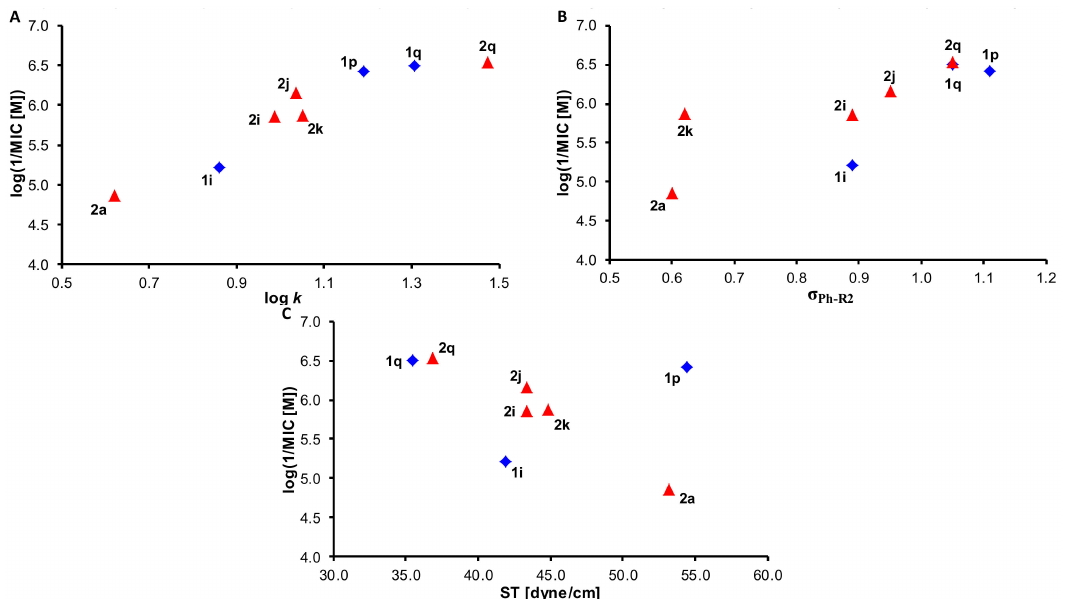
Figure 3. Relationships between in vitro activity against S. aureus ATCC 29,213 log(1/MIC [M]) and lipophilicity expressed as log k ( A ), electronic σ parameters of ring-substituted anilide ring ( B ) and and surface tension ( C ) of studied compounds. (blue rhombuses = series 1 , red triangles = series 2